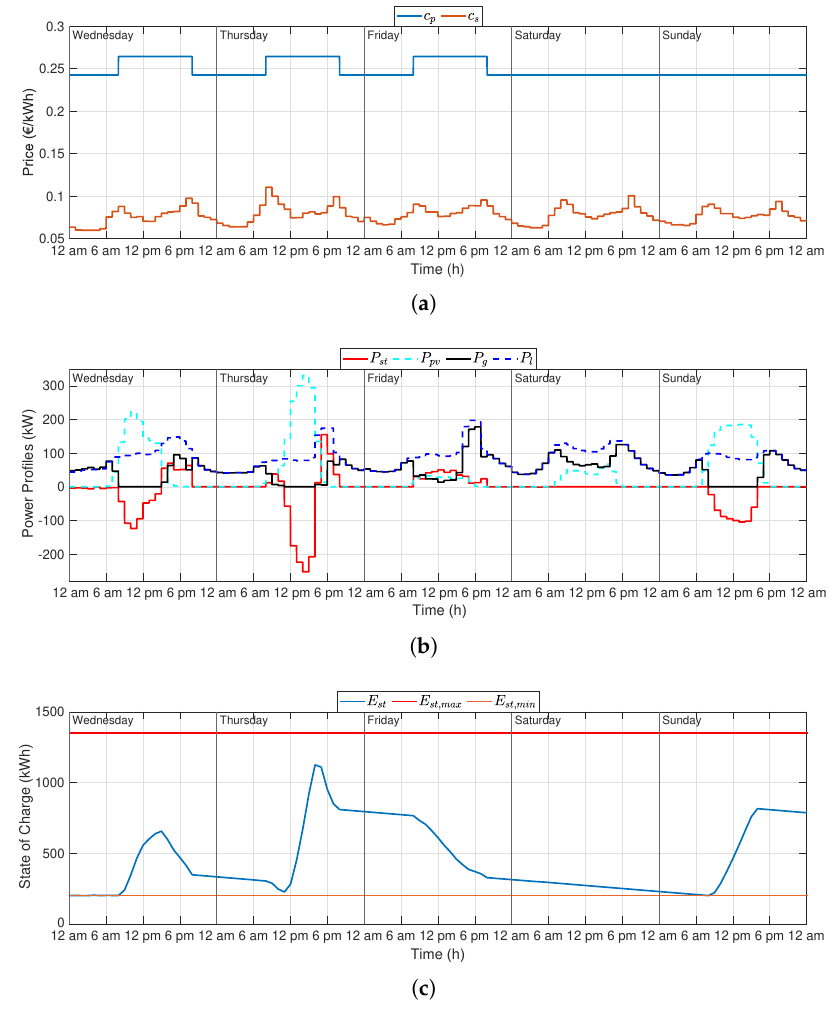
Figure 7. MPC results with Italian prices in a simulation of five days: ( a ) Cost and revenue of energy; ( b ) Power Profiles; ( c ) State of